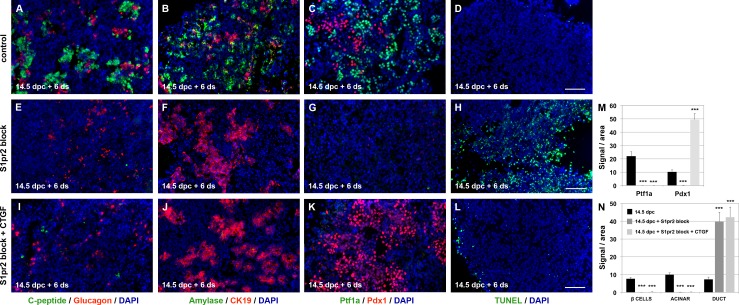
S1pr2 signalling promotes survival and lineage specification of pancreas progenitors.(A-H, M, N) Immunofluorescence analysis showed that S1pr2 block with 15 μM JTE013 in ALI cultures of 14.5 dpc embryonic pancreata for 6 d (14.5 dpc + 6 d) lead to the elimination of C-peptide+ endocrine cells (A, E, N) and Amylase+ acinar cells (B, F, N) and to a greatly expanded number of CK19+ duct-like cells (B, F, N). Markers of mature β cells (Pdx1) and acinar cells (Ptf1a) were also eliminated upon S1pr2 block (C, G, M), and cell survival was severely compromised, as shown by TUNEL immunofluorescence analysis (D, H). (I-L, M, N) Immunofluorescence and TUNEL analysis showed that addition of CTGF in the ALI cultures along with the S1pr2 block virtually eliminated cell death (L), without reversing the loss of C-peptide+ endocrine (I, N), Amylase+ acinar cells (J, N). A large number of CK19+ duct-like cells (J, N) and Pdx1+ cells (K, M) persisted. Scale bars, 80 μm (A, B, D-F, H-J, L) and 70 μm (C, G, K); ***p < 0.001; error bars show SD. For raw data please refer to the S1 Data file.